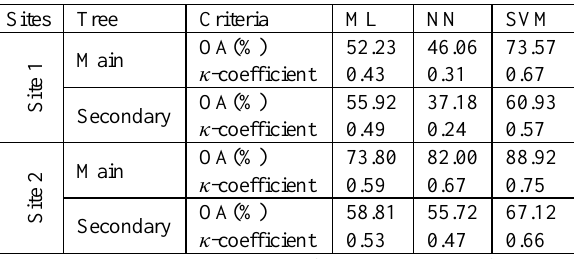
Table 3: The resulting classification accuracy, after implementing three classifiers for main and secondary trees. The highest accuracy was obtained for both the main and the secondary group when using SVM (Table 3). The overall accuracy of the main and the secondary trees at Site 1 equals 73.57% and 60.93%, with a κ- coefficient equal to 0.67 and 0.57, respectively. Meanwhile, the resulting overall accuracy of the main and secondary trees at Site 2 equals 88.92% and 67.12% with a κ- coefficient equal to 0.75 and